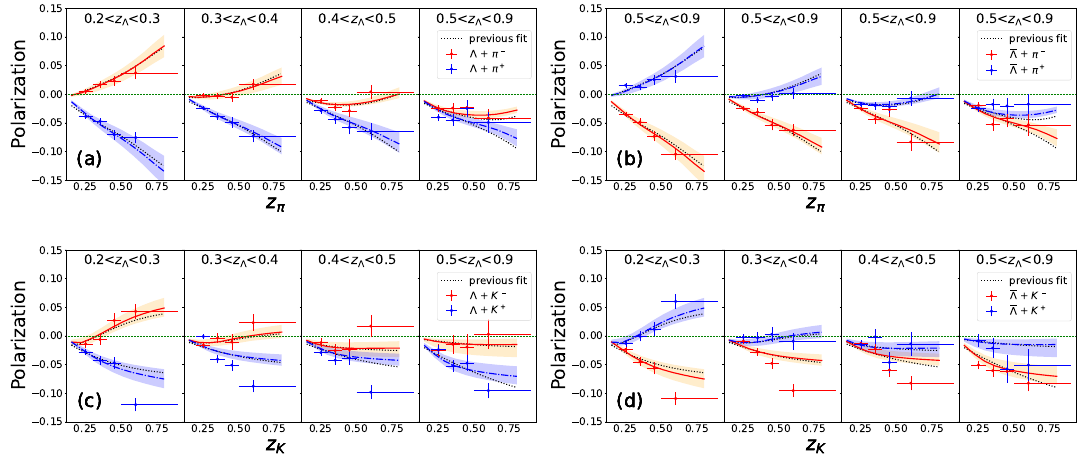
Figure 6 . Best-fit estimates (Gaussian model with the parameters of table 2) of the transverse polarization for Λ , ¯Λ in e + e − → Λ(¯Λ) h + X , for Λ π ± (a), ¯Λ π ± (b), Λ K ± (c), ¯Λ K ± (d), as a function of z ( h = π, K ) for different z bins. Data are from Belle [28]. The statistical uncertainty bands, h Λ at 2 σ level, are also shown. Data for z 0 . 5 are not included in the fit. The results of the fit of π,K > ref. [32] (dotted line) are also